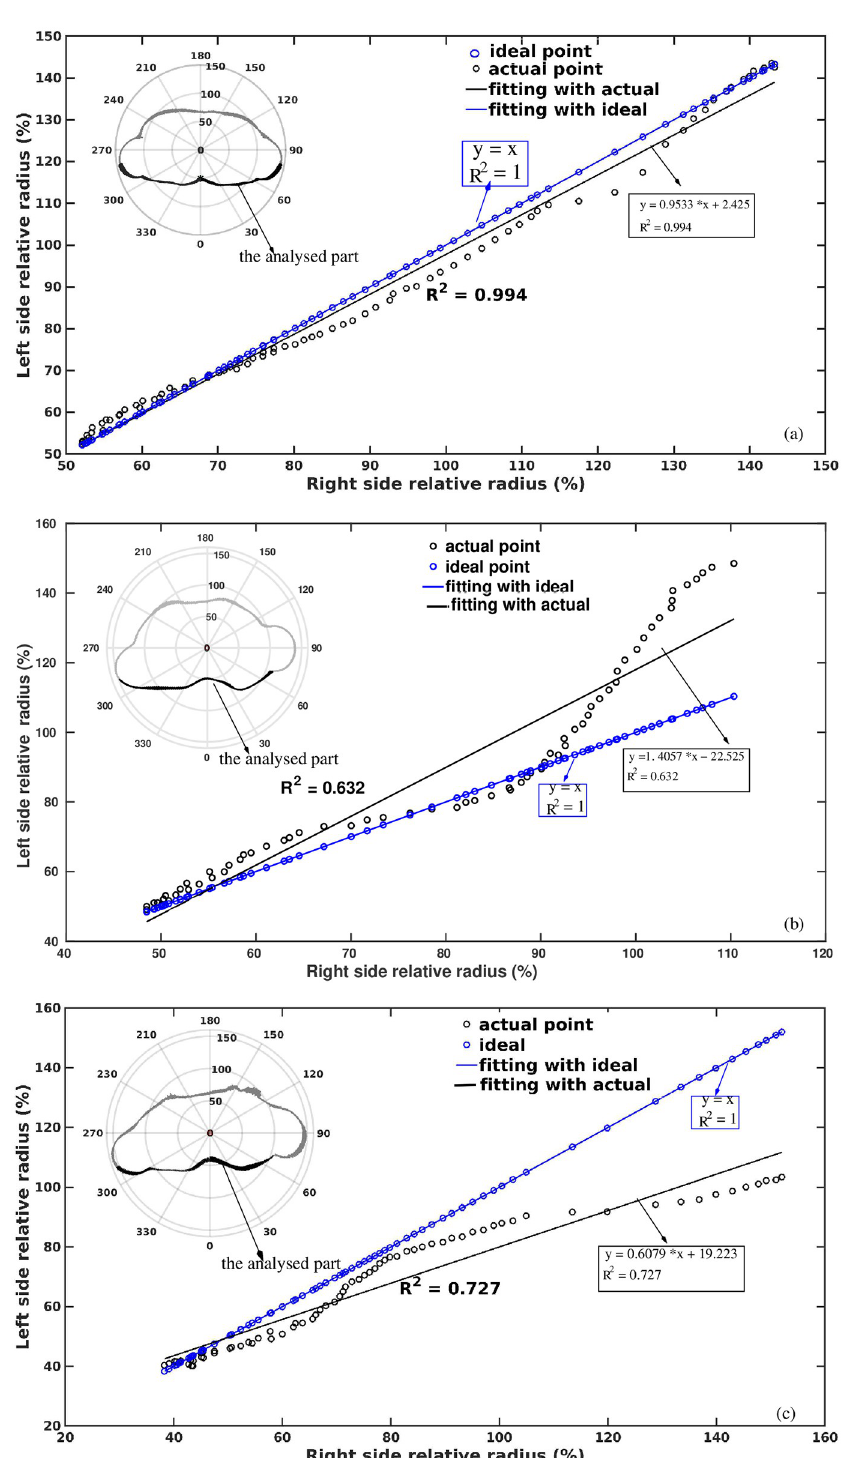
Fig 4. Correlation between two back sides. Correlation between the left and the right side of the normalized back side radii of the 2D transverse cross-section of the torso, (a) from healthy control, (b) and (c) from the patient at the time of her first scan and during a follow-up examination respectively. Black circles are the extracted original scattered points from the contour, blue circles indicate the ideal (symmetrical) shape. The linear trend of the transverse section has: a black line indicating the original shape, and a blue line indicating the ideal symmetric shape. The insets show the corresponding transverse cross-sections. Indicated are also the values of R 2 , that characterize the asymmetry of the backside torso contour shown